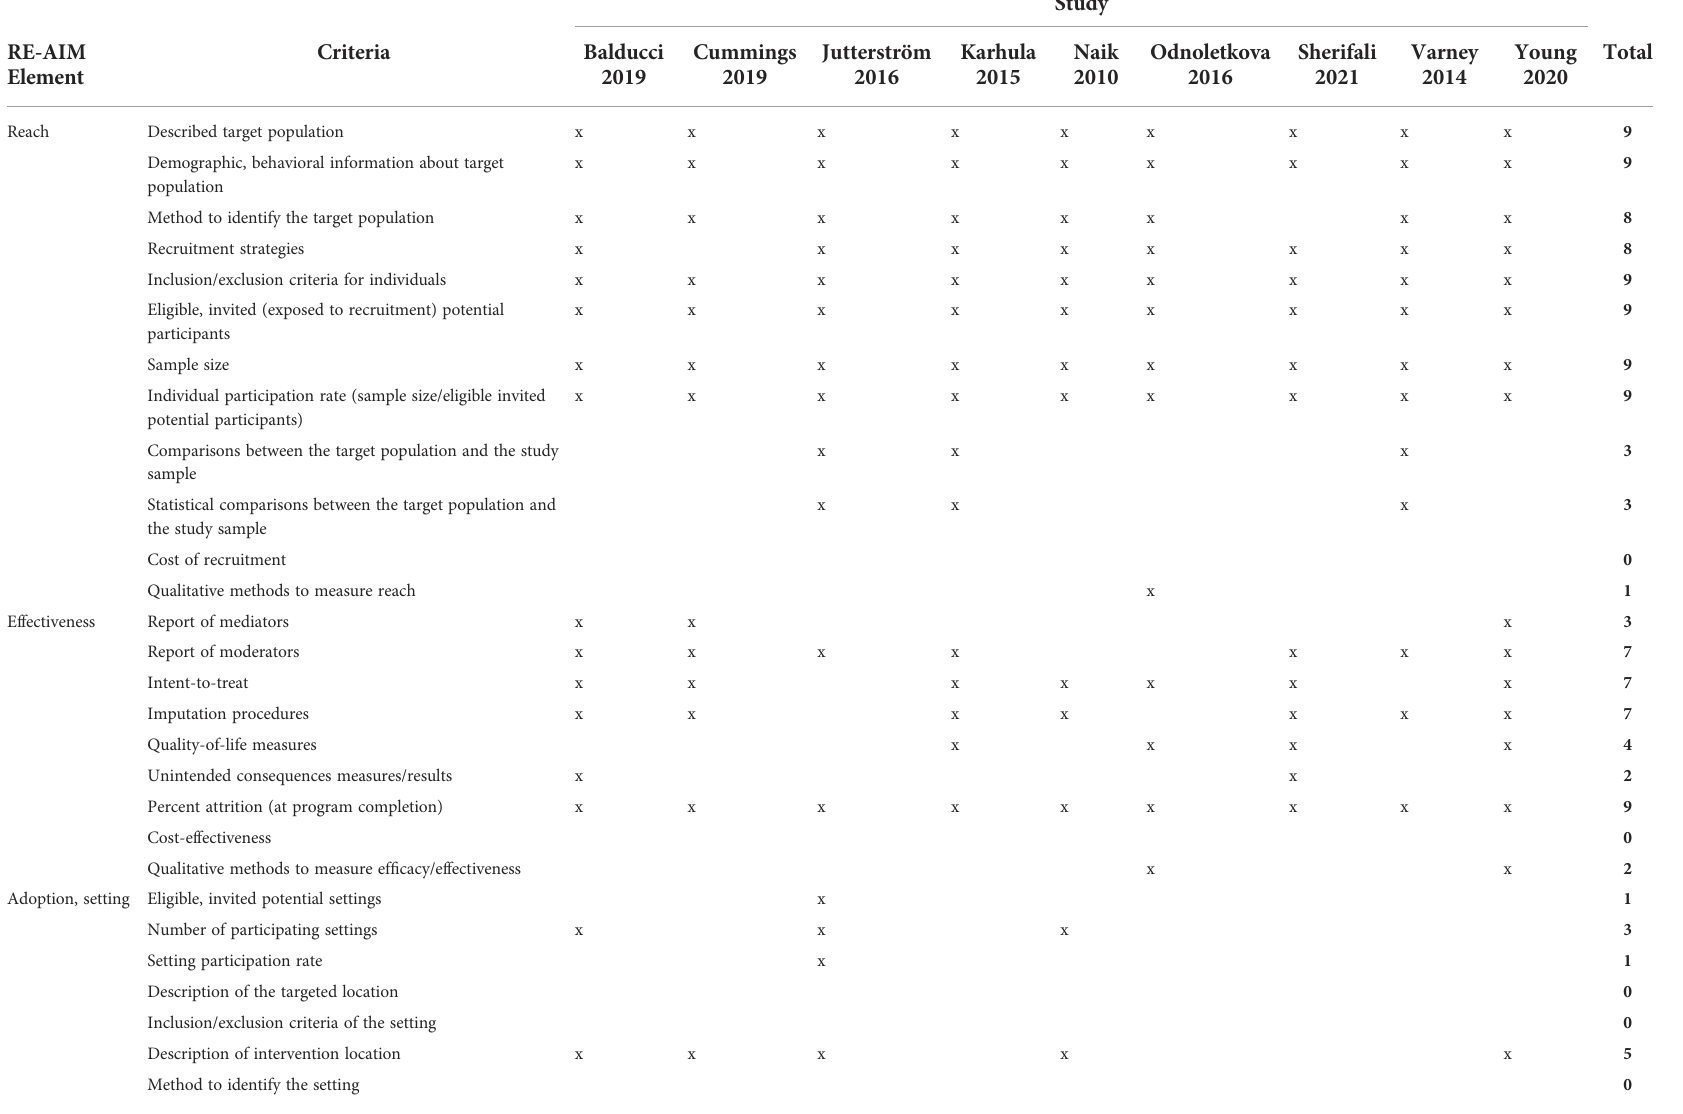
TABLE 2 RE-AIM criteria included in each study.